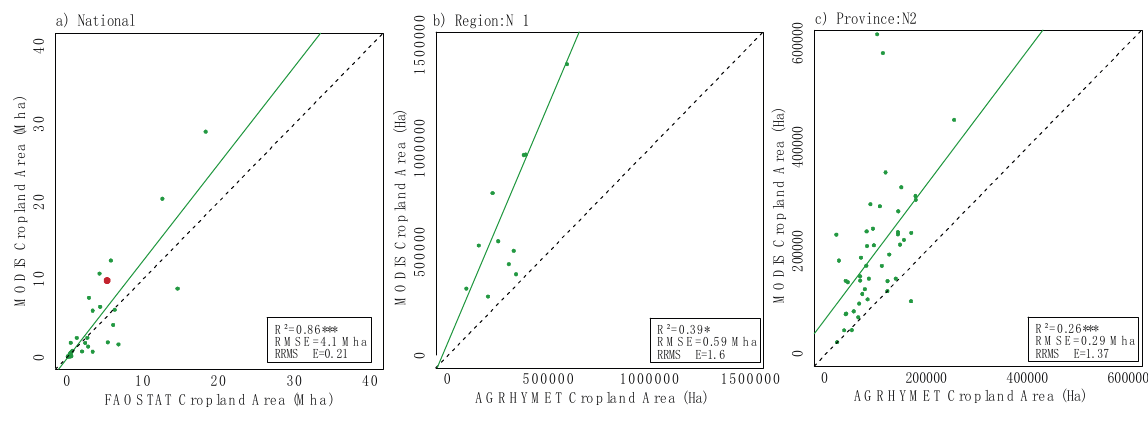
Figure 3. Crop area averages (2001–2011) calculated from the MODIS LCP data (y-axis) plotted against the FAOSTAT/AGRHYMET data (x-axis) for ( a ) the national level (29 countries), where the red dot represents Burkina Faso; ( b ) the 12 regions (N1: level 1 below national) and ( c ) the 45 provinces (N2: level 2 below national) of Burkina Faso. The diagonal dashed lines represent the 1:1 lines. The MODIS LCP cropland area is equal to the sum of class 12 and class 14 with a weight of